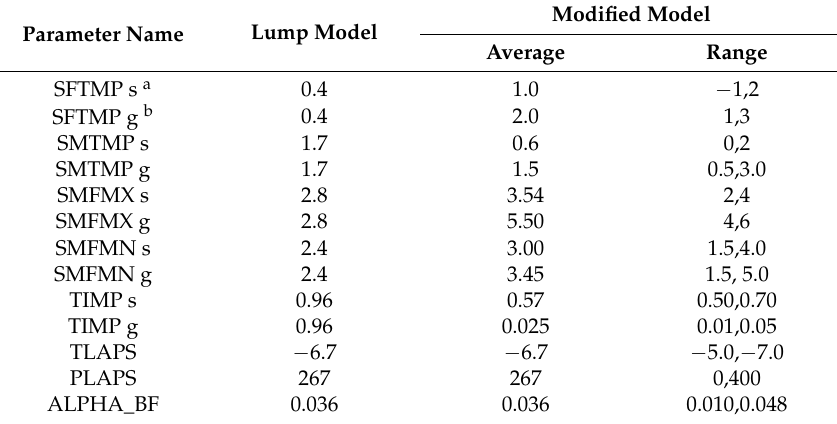
Table 4. Range and mean values of calibration parameters in subbasin-elevation band scale, Rhone River Basin.